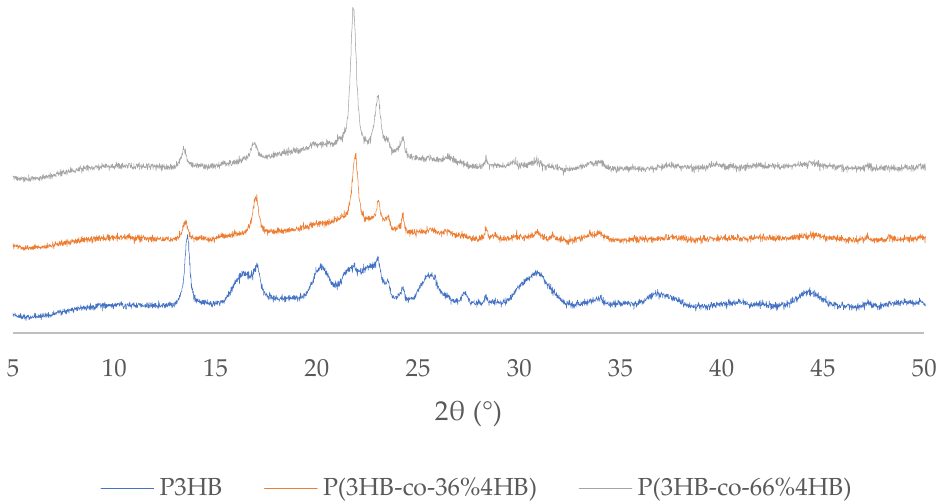
Figure 5. X-ray Diffraction patterns indicating different crystalline morphology of P3HB and the P(3HB- co -4HB) copolymers.